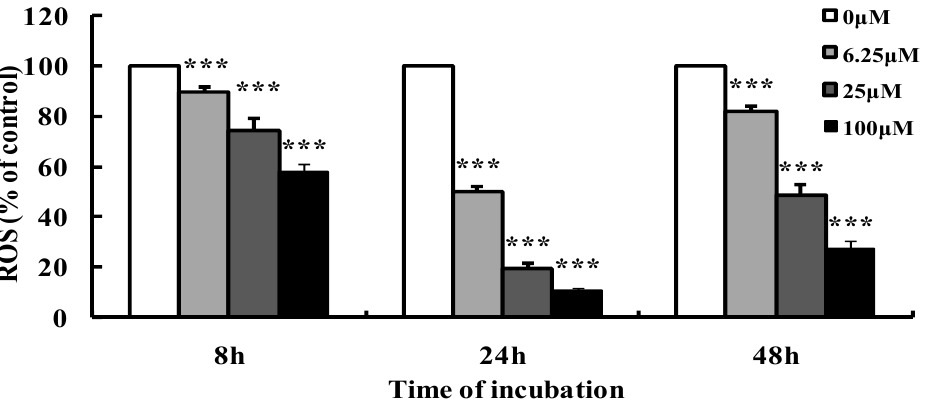
Figure 7. Effects of luteoloside on intracellular reactive oxygen species (ROS) levels in Hela cells. Cells were treated with various concentrations of luteoloside for the indicated time, and then incubated with 10 µ M 2 (cid:48) ,7 (cid:48) -dichlorodihydrofluorescein diacetate for 20 min. 2 (cid:48) ,7 (cid:48) -dichlorodihydrofluorescein